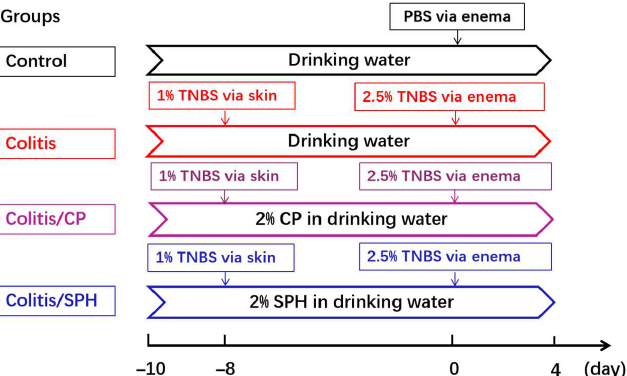
Figure 1. Experimental design for acute TNBS-induced mouse colitis model. Colitis (n = 8) was in- duced by cutaneous sensitization with 1% TNBS followed by enema challenge with 2.5%